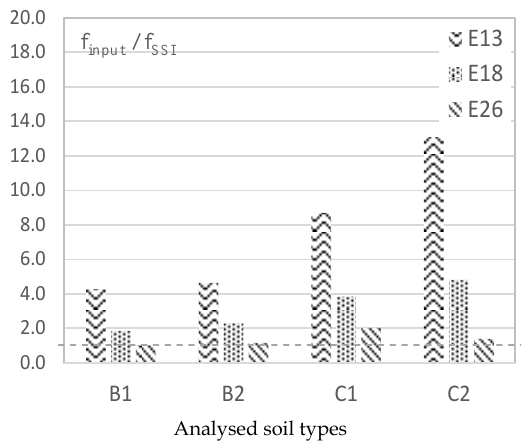
Figure 16. Comparison between the input frequencies f input and the soil frequencies f SSI for the SS alignment (visco-nonlinear analyses).